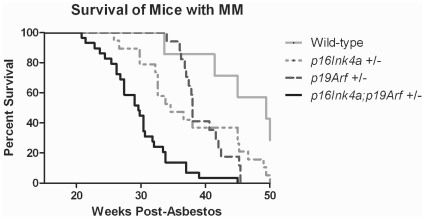
Accelerated asbestos-induced MM in mice deficient for Ink4a, Arf, or Ink4a;Arf.Kaplan-Meier survival curves (GraphPad Prism 5). Mice with no tumors or with incidental tumors were censored. A log-rank test verified significant differences between wild-type and Ink4a-, Arf- and Ink4a;Arf-deficient groups (p-value = 0.0342, 0.0312, and <0.0001, respectively).